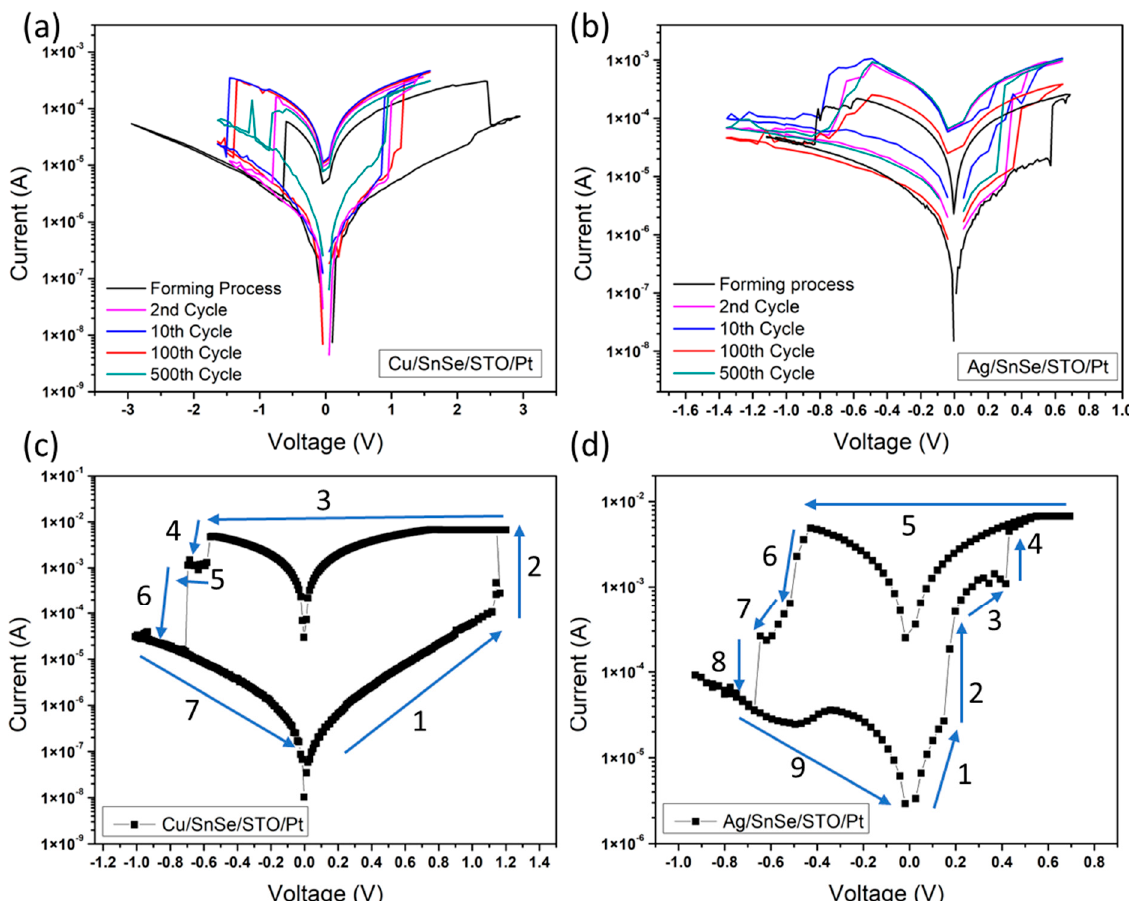
Figure 3. ( a ) The I–V curves of the Cu/SnSe/STO/Pt device and ( b ) the Ag/SnSe/STO/Pt device at the 500th applied voltage sweeps. The SET process and RESET process of the Cu/SnSe/STO/Pt device ( c ), and the Ag/SnSe/STO/Pt device ( d ).